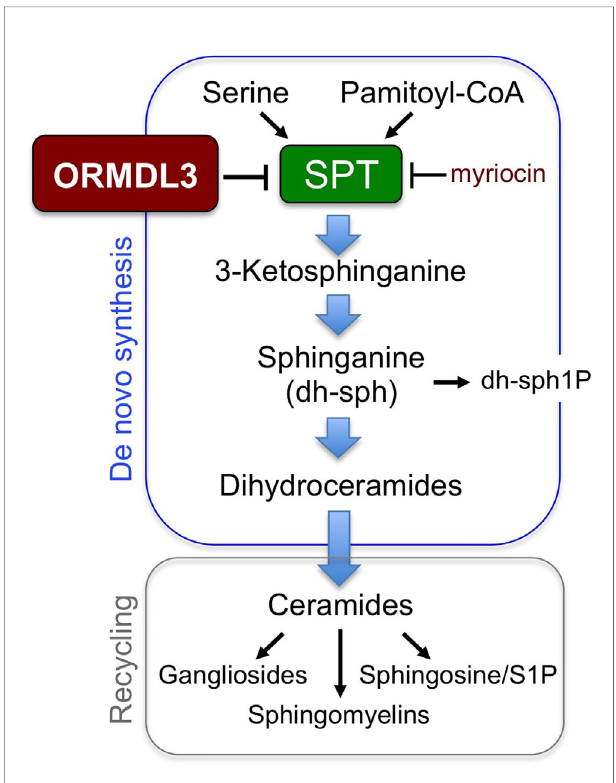
FIGURE 1 | Sphingolipid synthesis pathways. ORMDL3 regulates the activity of serine palmitoyl-CoA transferase (SPT), the fi rst and rate-limiting enzyme for sphingolipid